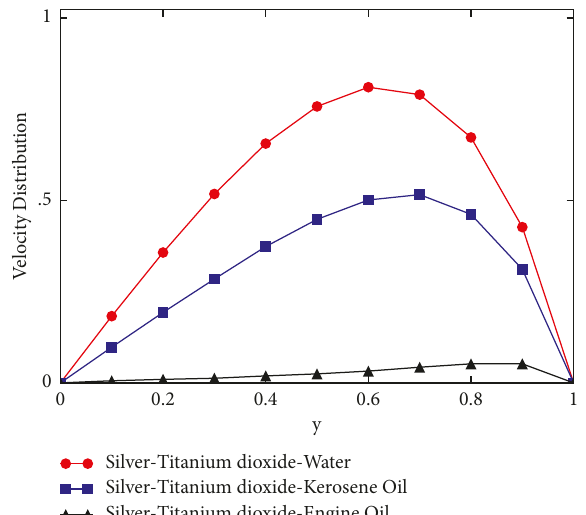
Figure 12: Comparison among base fluids (engine oil, water and kerosene) for velocity after Q 0 . 08. ϕ hnf (cid:30)